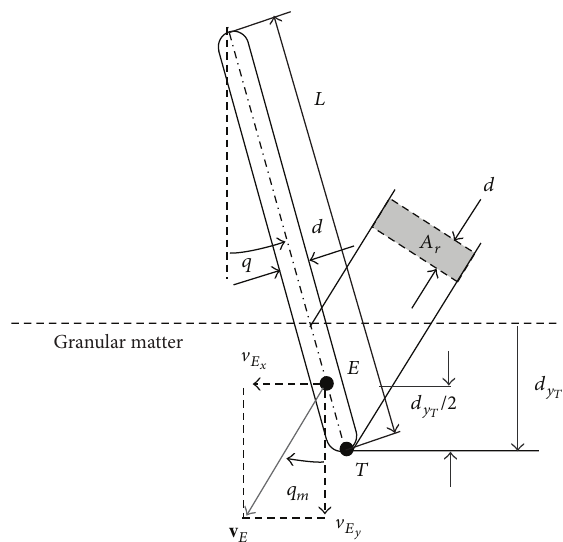
Figure 1: The reference area and the physical parameters of the free